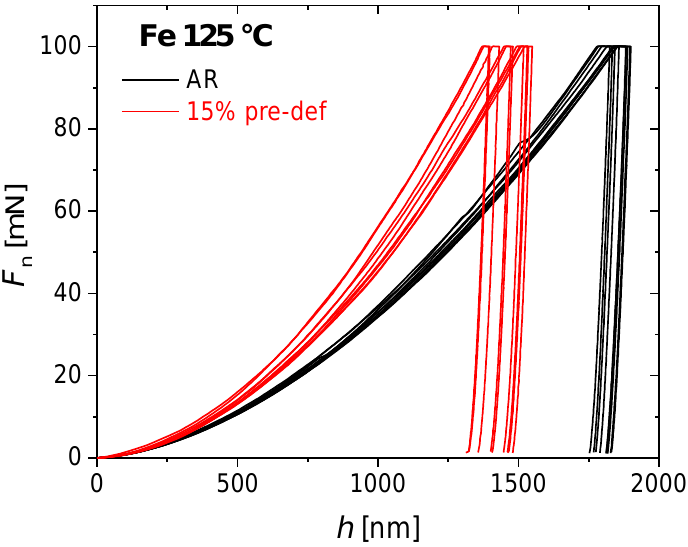
Figure 2. Indentation force vs. depth curves for two sets of repeated indents to 100 mN maximum force on the Fe-AR-125 and the Fe-15%-125 specimen, respectively.